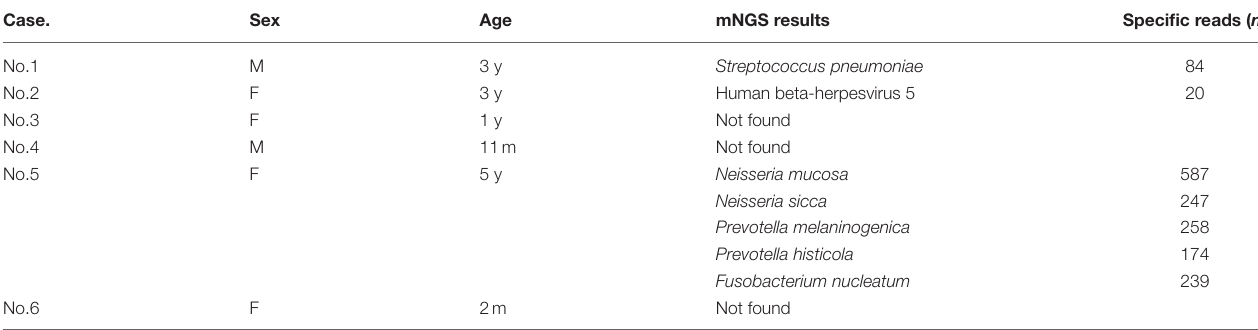
TABLE 2 | Infectious pathogens and metagenomic next-generation sequencing (mNGS) results.